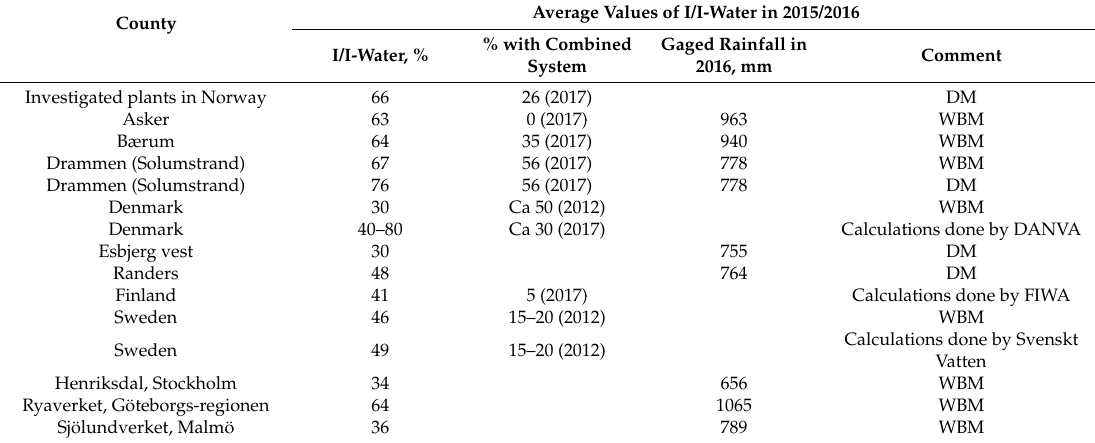
Table 13. Summary of results of studies on the Nordic countries of I/I-water in the wastewater systems for the years